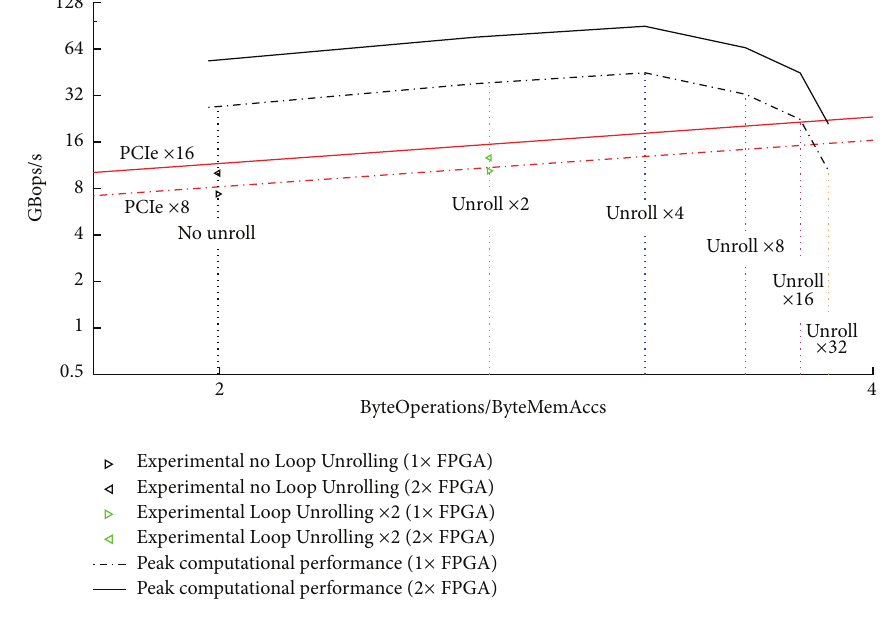
Figure 6: Superimposed performance models of one FPGA (dashed lines) and two FPGAs (continuous lines) of dilation using ROCCC.